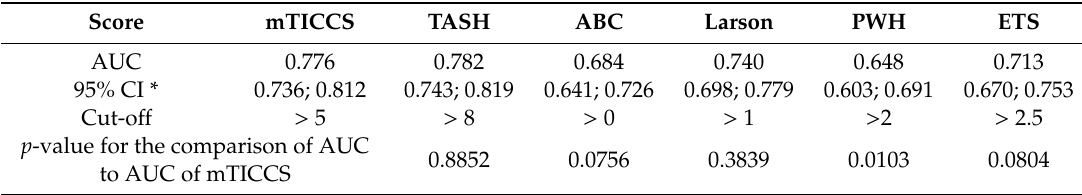
Table 3. Comparative area under the curve (AUC)